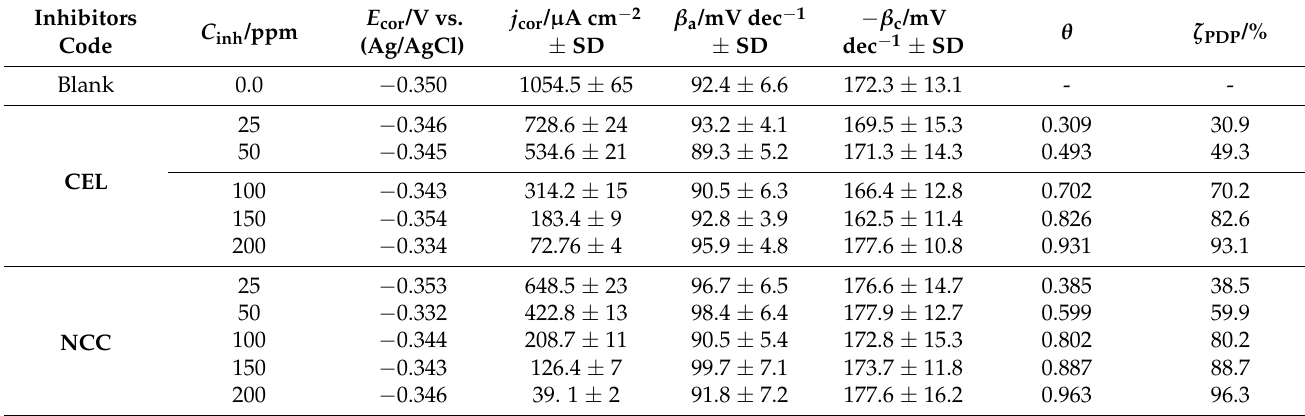
Table 1. PDP parameters obtained for SS316 alloy in 2.0 M HCl solution in the lack (blank) and existence of different concentrations of CEL and NCC at 50 ◦